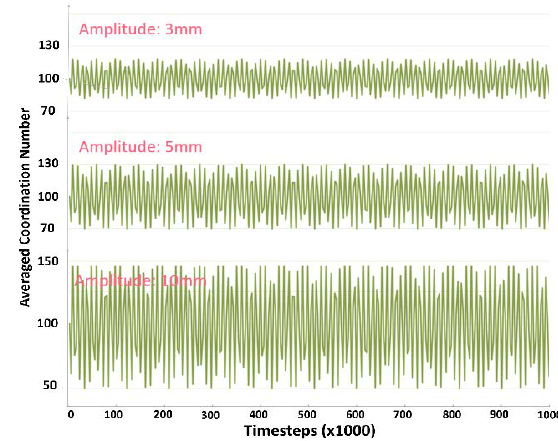
Fig. 5. Time evolution of ACN with different vibration amplitude. Note that the recorded ACN is quite similar for the three cases. The BNE only occurs in the case with the amplitude at 10 mm. Vibration frequency: 20 Hz.